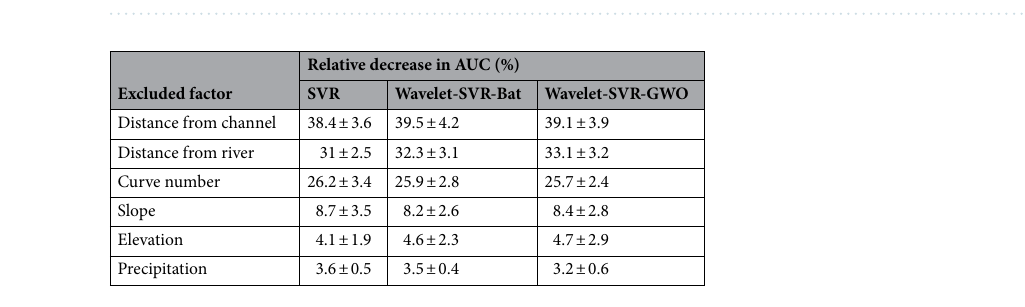
Figure 9. Pairwise agreement plots (PAP) showing results of pair-wise comparisons between: ( a ) SVR and Wavelet-SVR-Bat, ( b ) SVR and Wavelet-SVR-GWO, and ( c ) Wavelet-SVR-Bat and Wavelet-SVR-GWO.